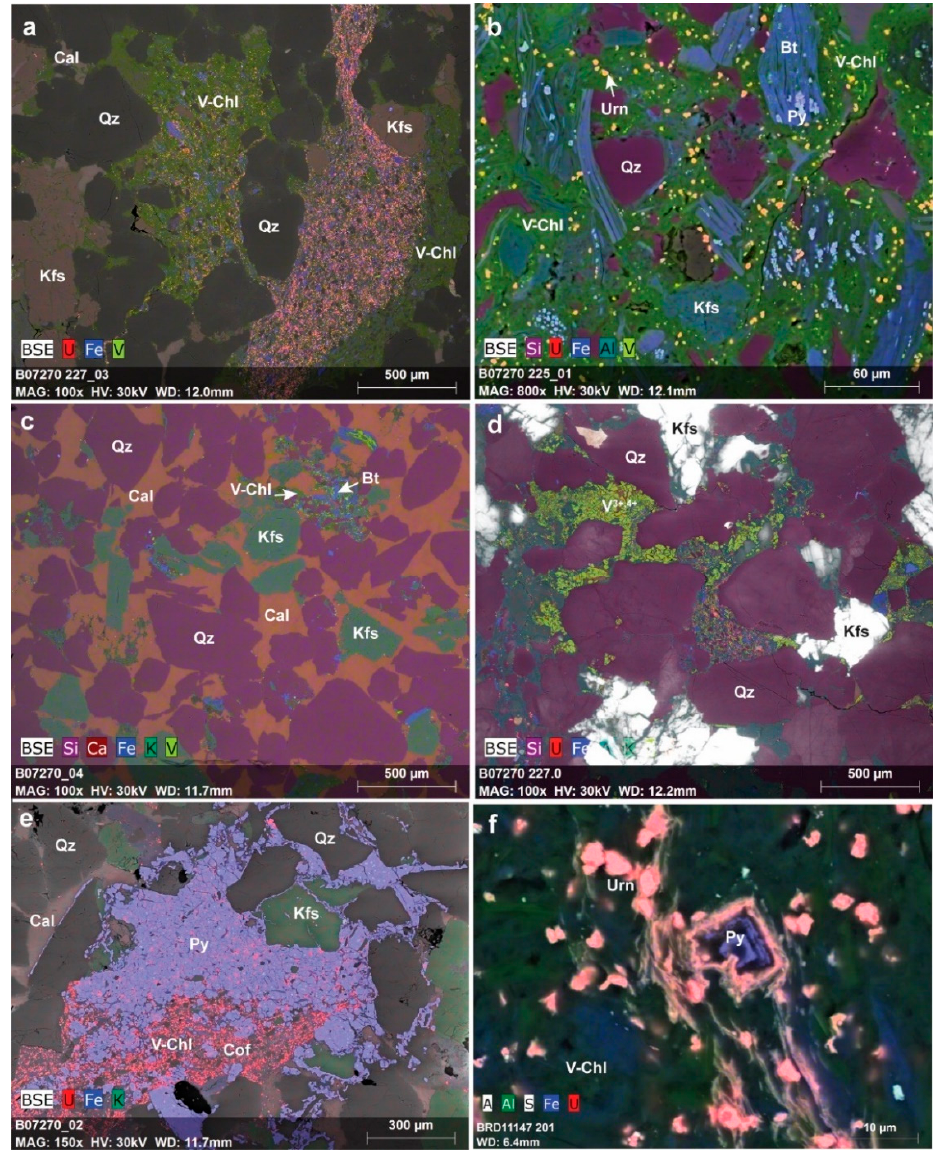
Figure 10. BSE-EDS micrographs illustrating V-minerals textures, ( a ) detail of compositionally diverse clay-rich lithic clasts showing V-rich and U-rich domains; ( b ) detail of a V-clay-rich domain of a lithic clast showing V-chlorite/corrensite (green) with imbedded disseminated fine-grained uraninite, pyrite framboids and altered pyritized biotite; ( c ) calcite-cemented domain in which the pore-space and grain boundaries have been invaded and flooded by calcite prior to compaction; ( d ) composite SEM/CL image of a V-rich domain showing intergranular matrix composed of V-chlorite and aggregates of bladed montroseite crystals; fractured K-feldspar grains show radiation damage along fractures, yet there is no contact with U-minerals; ( e ) late pyrite aggregate in a U-mineralized domain; ( f ) early pyrite skeletal crystallite replaced by uraninite within V-chlorite. Pyrite may be present in di ff erent generations in mineralized In some V-rich samples that lack uranium or evidence of previously residing uranium, a different detrital provenance is recognized among the lithic clasts. The clasts are composed of rounded quartz grains and minor K-feldspar without radiation-induced damage bonded by silica